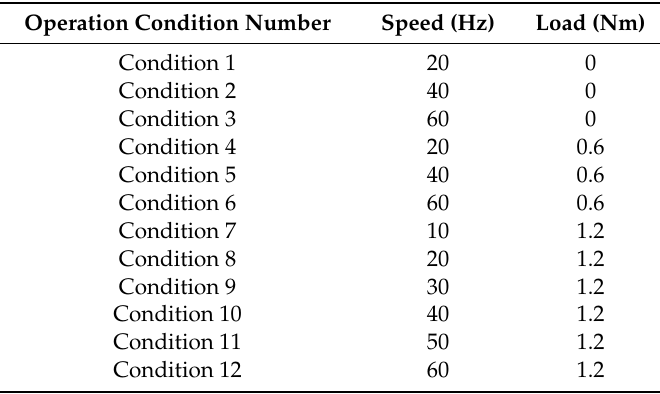
Figure 6. Test bed of planetary gearbox. Table 2. The description of signal operation conditions.